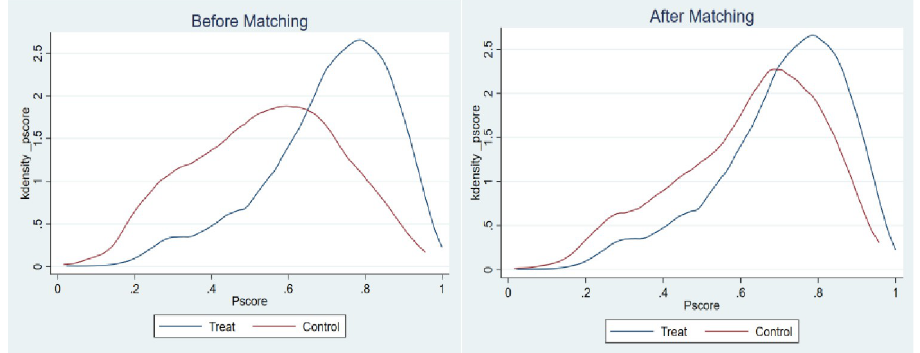
Fig 4. Y3: Comparison of the PS probability values between “rural households who participated in the appraisals” and “rural households who did not participate in the appraisals” before and after nearest neighbor matching.